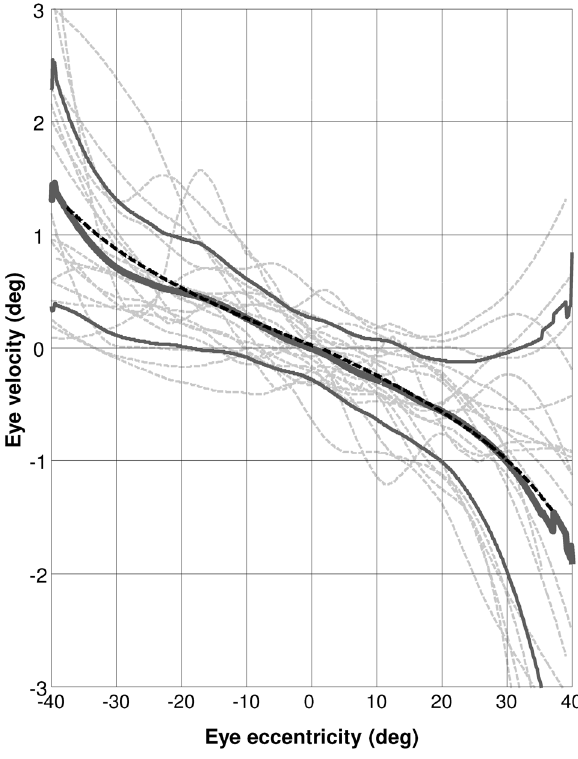
Figure 4. Smoothed Position -Velocity plot of the whole population. Dashed gray lines: Individual position-velocity curves obtained after smoothing and interpolating instantaneous velocity as a function of eye eccentricity; solid thick gray line: mean of the smoothed individual position-velocity curves; solid medium gray line: mean 6 1 standard deviation of the smoothed individual position-velocity curves; dashed black line: tangent fit of the mean of the smoothed individual position-velocity